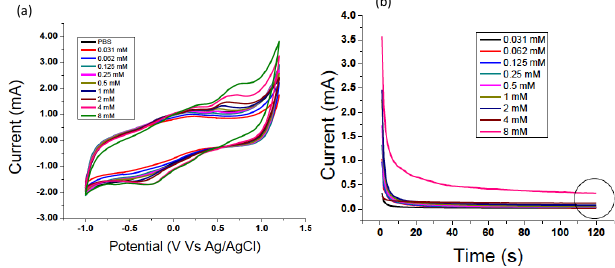
Figure S4. (a) CV and (b) chronoamperometry curves of serotonin with different concentrations in PBS. The circle in (b) shows the times at which the current measurements were acquired for Figure A1. ( a ) CV and ( b ) chronoamperometry curves of serotonin with different concentrations in Figure 3a in the main paper. In all cases, electrode surface was 700 µm x 700 µm. PBS. The circle in ( b ) shows the times at which the current measurements were acquired for Figure 12a in the main paper. In all cases, electrode surface was 700 µ m × 700 µ m.